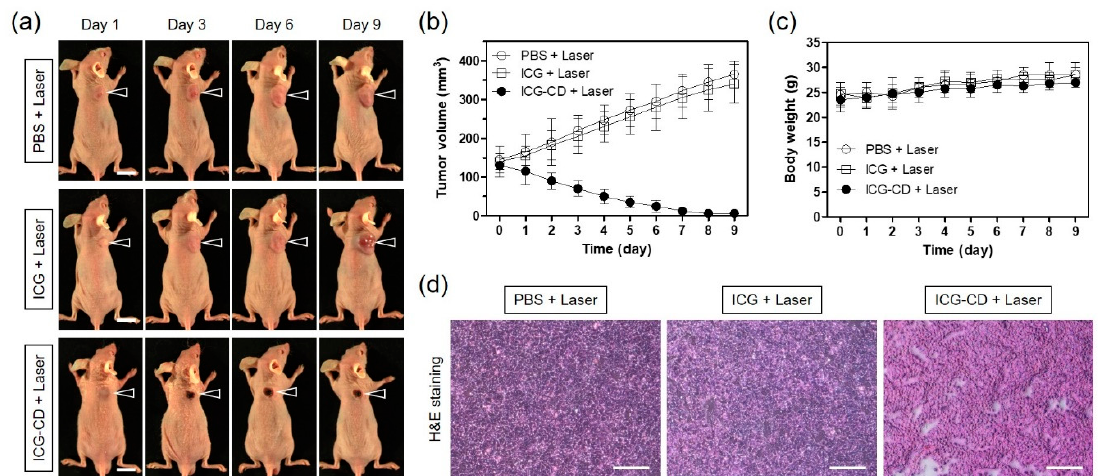
Figure 6. ( a ) In vivo NIR phototherapeutic e ffi cacy. Representative images showing changes in tumor size with 4 h post-injection of PBS, ICG, and the ICG-CD complex, followed by 808 nm laser irradiation (1.1 W / cm 2 ) for 5 min. The tumor site is indicated by an arrowhead. Scale bars = 1 cm. ( b ) Tumor growth rate and ( c ) body weight of each treatment group were monitored for 9 days. Data are expressed as the mean ± S.D. of three independent experiments. ( d ) Tumor sections from each group stained with H&E at 24 h after laser irradiation. Scale bars = 100 µ